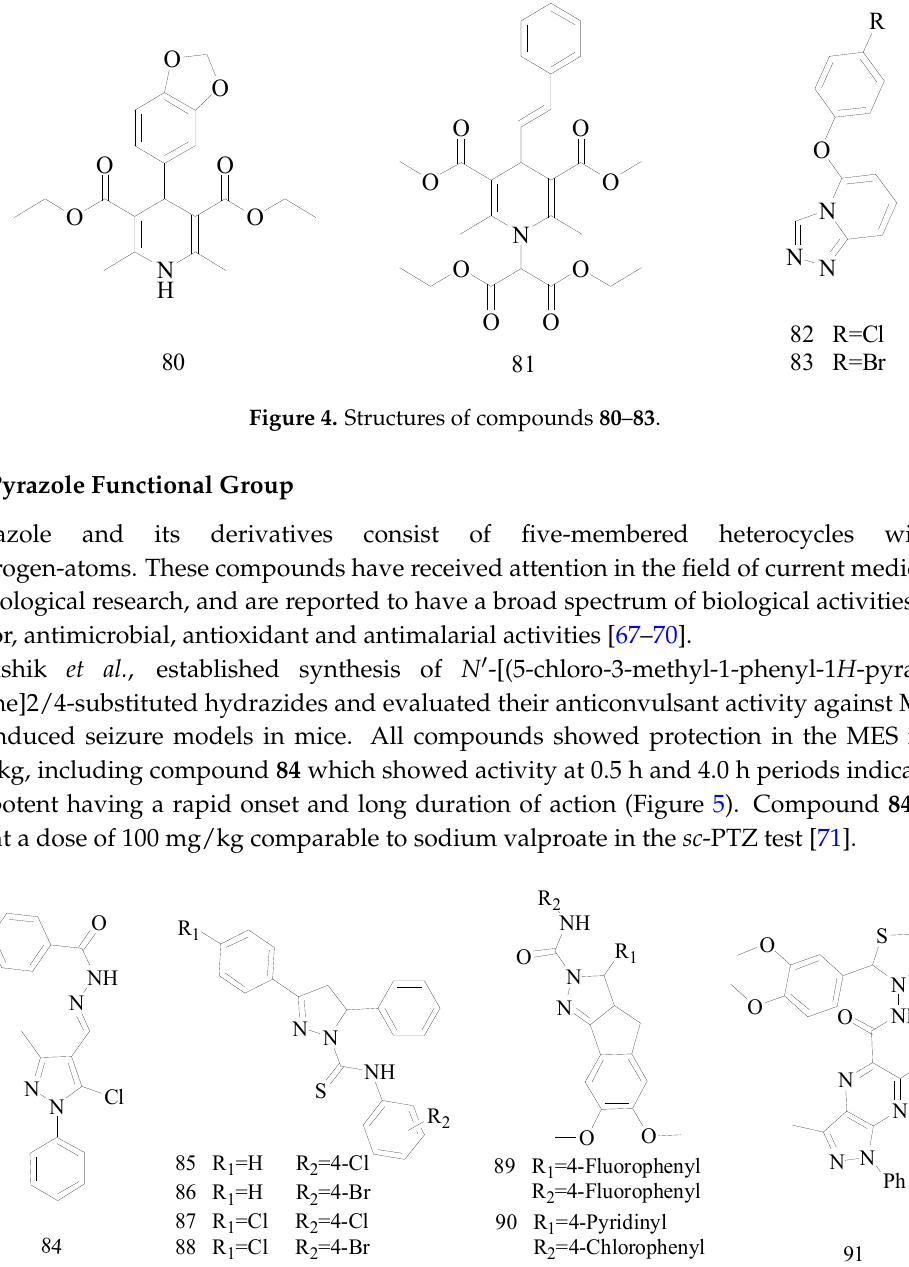
94 Figure 6. Structures of compounds 92 – 94 . Husain et al. , established a synthesis of a series of 1,2,4-trisubstituted-1 H -imidazole derivatives. Anticonvulsant activity was shown by the majority of the synthesized compounds in the MES and sc -PTZ screening when given i.p. to mice. In anticonvulsant screening, only one compound, 93 , showed potent activity comparable to that of standard drugs phenytoin and carbamazepine (Figure 6) [79].